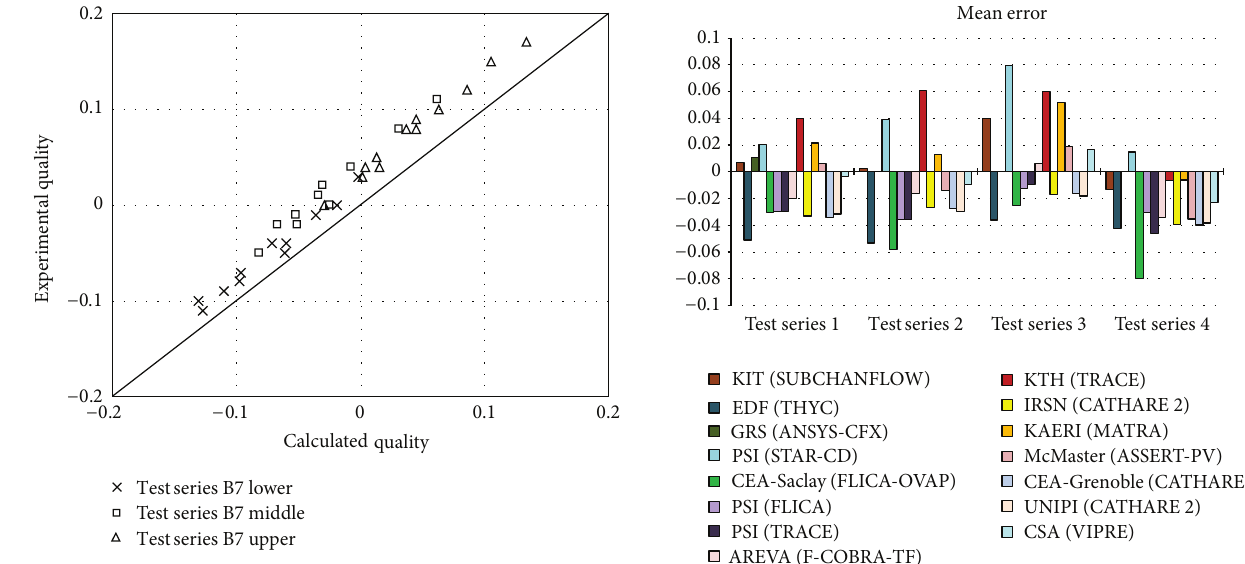
Figure 21: Void fraction mean error by test series.